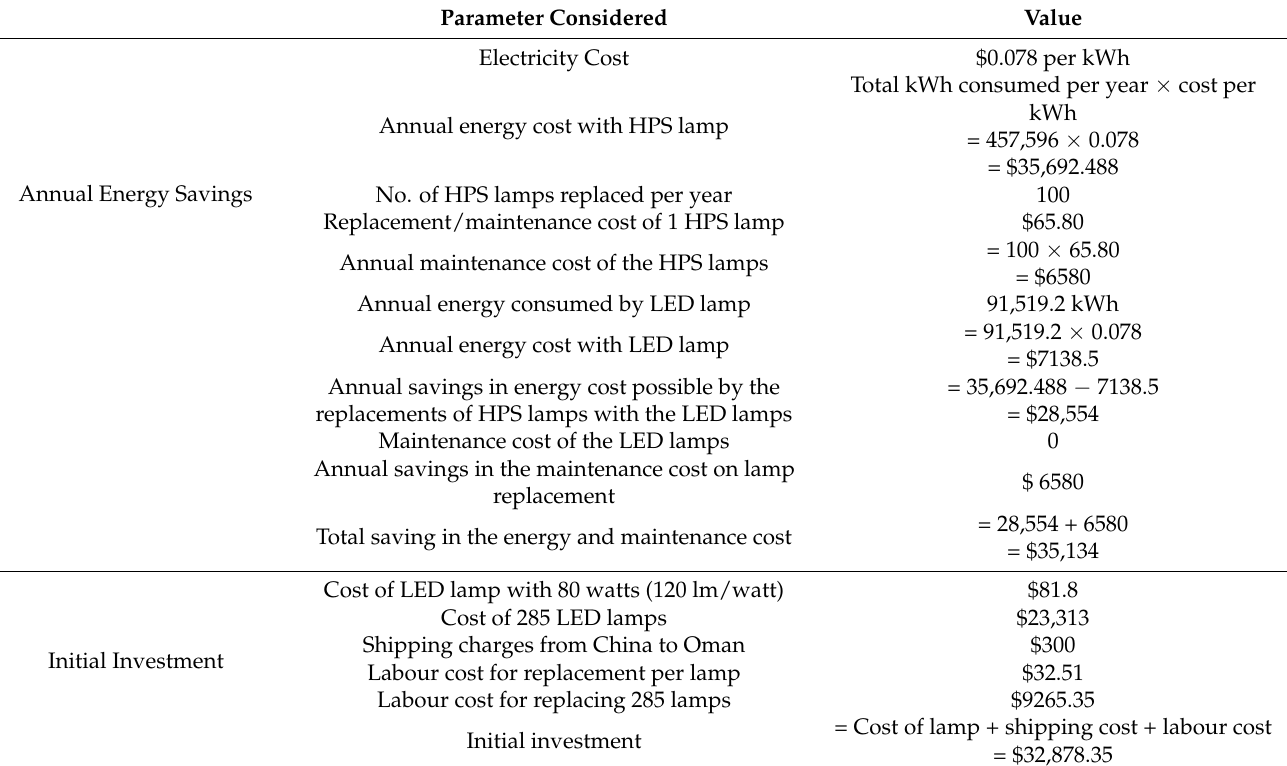
Table 4. Economic analysis of replacing HPS lamps with LED